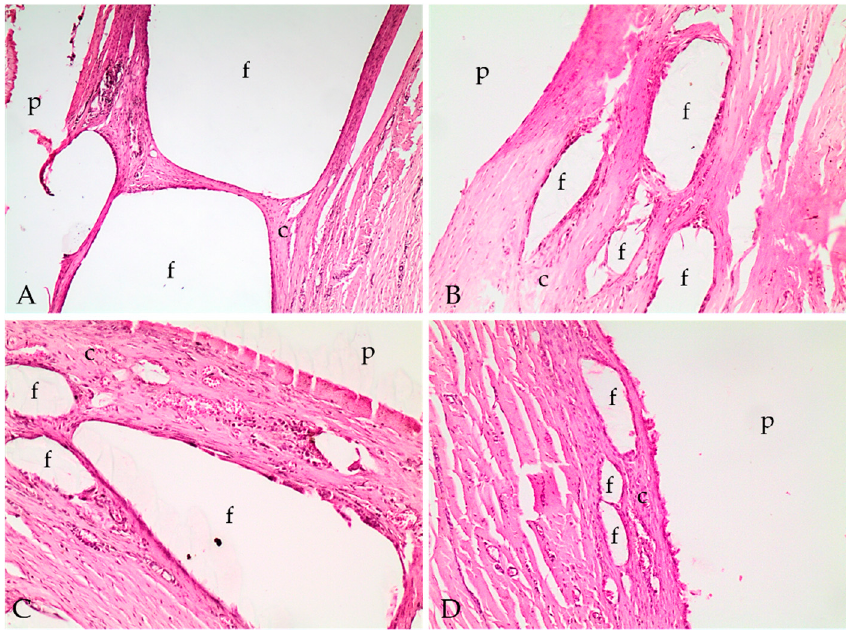
Figure 3. Photomicrographs of implant polymer sites with the capsular formation (c), polymer (p) and cellular growth with fragmentation of the polymer (f). ( A ) Cellular growth and polymer fragments at 24 weeks; ( B ) 28 weeks; ( C ) 34 weeks; and ( D ) 38 weeks. Hematoxylin and eosin stain; 40× ( A ) and 100× ( B – D ).